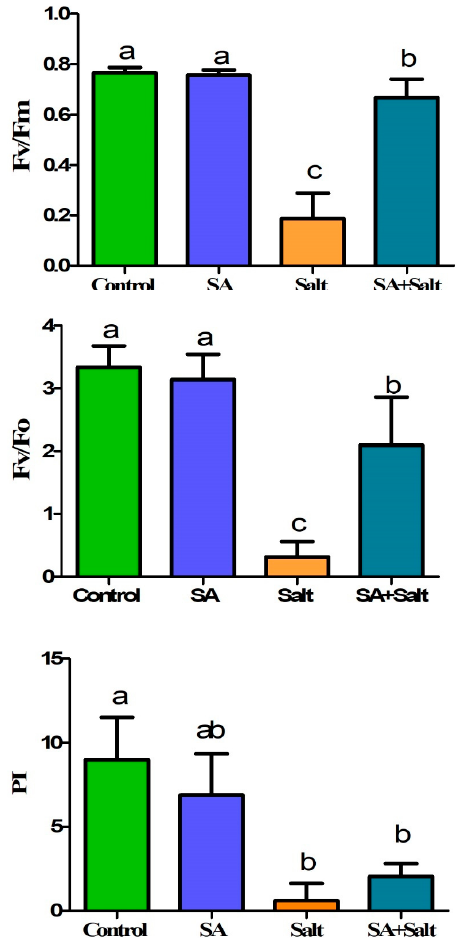
Figure 4. Effect of salicylic acid application on St. John’s wort photosynthetic parameters under salt stress “Fv/Fm; photosynthetic efficiency, Fv/Fo; potential activity of PSII, PI; photosynthesis relative vitality”. Treatments: control, SA (0.25 mM salicylic acid), salt (150 mM NaCl), SA (0.25 mM salicylic acid) + salt (150 mM NaCl). Each value represents the mean ± SD ( n = 10). Different letters on each bar represent statistically significant differences as evaluated by DMRT and t ‐ test at p ≤ 0.05.